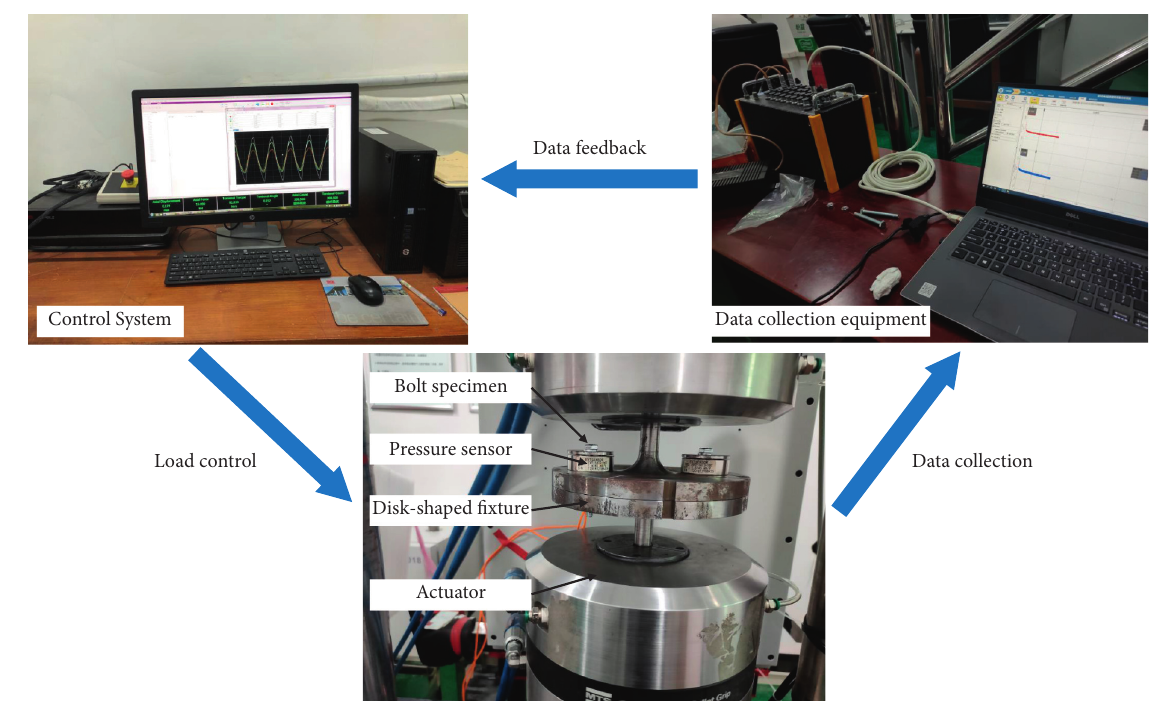
Figure 1: Schematic diagram of the test system. Table 1: Combinations of composite excitation in competitive failure